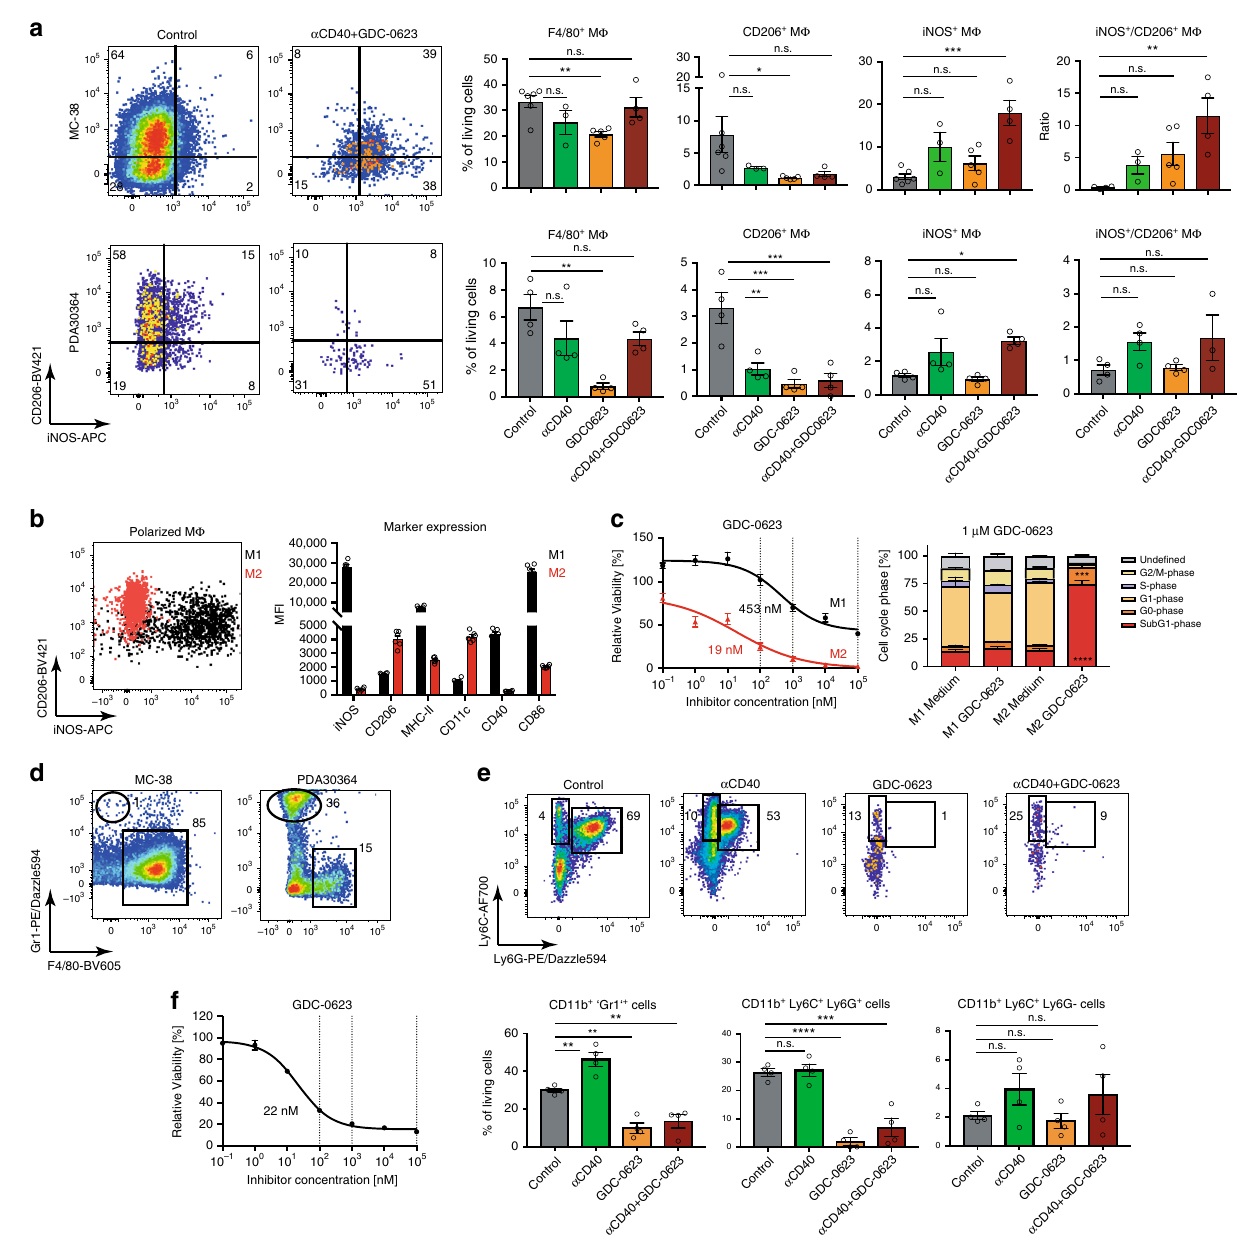
Fig. 5 MEKi suppress M2-like macrophages and MDSCs. a Flow cytometric analysis of the impact of MEKi GDC-0623 and/or anti-CD40 Ab treatment on the macrophage in fi ltrate in MC-38 and PDA30364 tumors, as performed on four mice per treatment group of the experiments shown in Fig. 3 b – c. Representative dot plots are shown. Cells were pre-gated on living CD45 + , CD11b + , F4/80 + cells. One-way ANOVA with post hoc Dunnetts ’ s test (treatment groups vs. control). Signi fi cance levels are indicated by asterisks (* p ≤ 0.05; ** p ≤ 0.01; *** p ≤ 0.001; **** p ≤ 0.0001). b Polarization of mouse bone marrow-derived macrophage cultures towards M1- or M2-like phenotype, as assessed by fl ow cytometry marker analysis. Mean±s.e.m, n = 6. c Cell viability of polarized macrophages after 3-day treatment with GDC-0623. Left panel: representative dose – response curves. Relative IC50 values were calculated by four-parameter logistic curve fi t with a bottom constraint > 0. Mean±s.e.m, n = 3. Right panel: Ki67/PI-based cell cycle analyses of tumor cells treated with 1 µ M GDC-0623 and respective quanti fi cation. Mean±s.e.m, n = 3. Unpaired student t test (medium vs. GDC-0623 for each cell cycle phase; FDR ( Q = 1%), two-stage step-up method of Benjamini, Krieger and Yuketieli). d Representative dot plots of myeloid cell populations in MC-38 and PDA30364 tumors. e Representative dot plots of 'Gr1 + ', Ly6C + Ly6G + , and Ly6C + Ly6G − myeloid cell populations in PDA30364 tumors. Cells were pre-gated on living CD45 + , CD11b + cells; quantitation normalized to all living cells. Mean±s.e.m, n = 4. One-way ANOVA with post hoc Dunnett ’ s test (treatment groups vs. control). F Cell viability of bone marrow-derived MDSC cultures after 3-day treatment with GDC-0623; assay performed as described above. Mean±s.e.m, n =